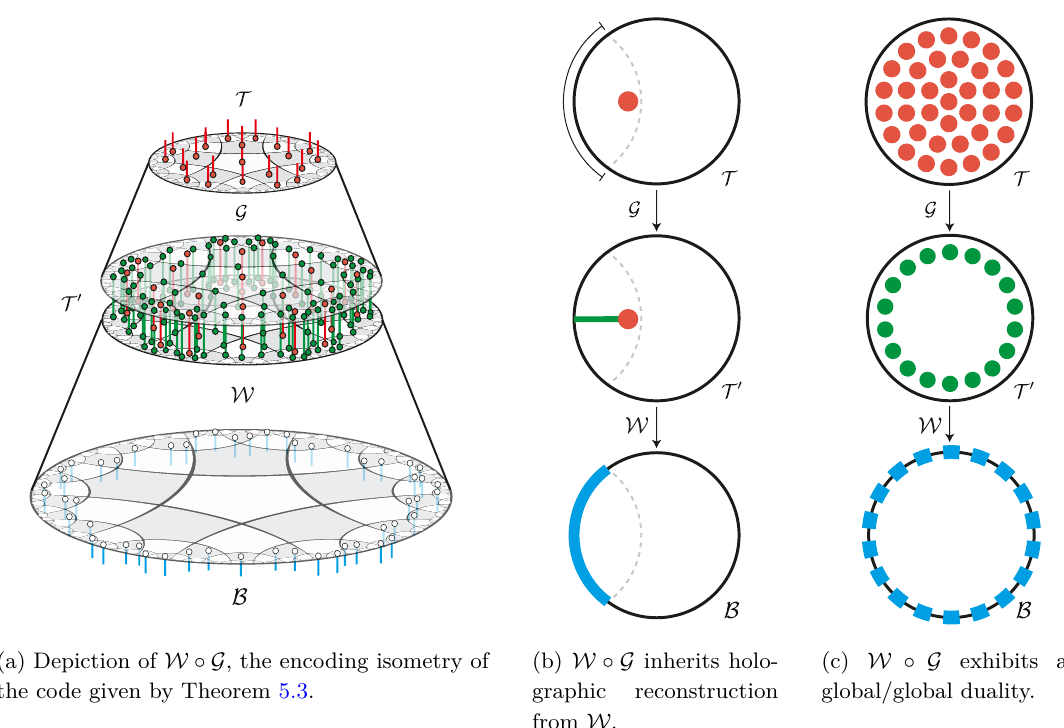
Figure 12. Basic components of the proof that any holographic code with a gauge/global symmetry duality can be converted into one with a global/global symmetry duality via Theorem 5.3. The structure is essentially the same as in Theorem 5.1 except that the T ’ may now have a full rather than fixed sector